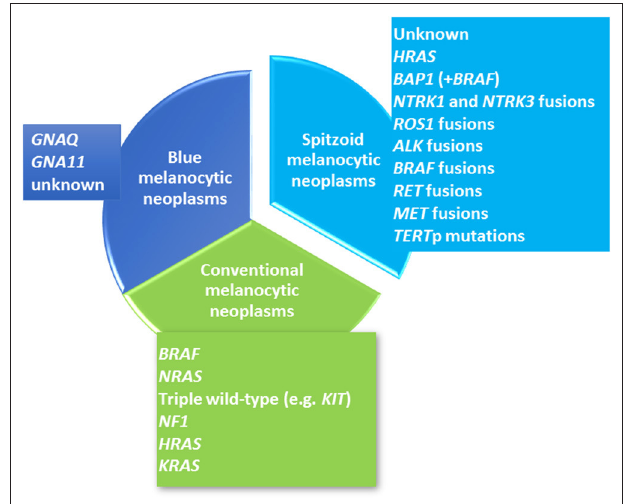
FIGURE 1 | Overview of the Molecular Landscape of Melanocytic Neoplasms. Cutaneous melanocytic neoplasms can be clustered into three major lines including conventional melanocytic neoplasms (colored in green), Spitzoid melanocytic neoplasms (colored in turquoise) and blue melanocytic neoplasms (colored in blue). Each group shows distinct molecular genetic alterations. Conventional melanocytic neoplasms (green color) include common melanocytic nevocellular nevi, congenital nevocellular nevi and cutaneous malignant melanoma. Common nevocellular nevi harbor activating hotspot BRAF mutations at codon 600 [ ∼ 80%, ( 1)]. The majority of congenital nevocellular nevi harbor activating NRAS hotspot mutations [ ∼ 75%, ( 2)]. Cutaneous malignant melanoma has been clustered into four molecular subtypes (3) with the largest subgroup harboring a BRAFV600E mutation ( ∼ 50%) and the second largest group with an activating NRAS mutation ( ∼ 25%) as well as HRAS and KRAS mutations ( ∼ 1%). The third subgroup shows NF1 inactivation ( ∼ 10%). The last molecular subgroup lacks BRAF, N/H/KRAS or NF1 mutations and represents a heterogeneous so called “triple wild-type subtype”. The second major line of cutaneous melanocytic neoplasms comprises blue melanocytic neoplasms which are also called dermal dendritic melanocytic neoplasms (blue color) and have been shown to harbor activating GNAQ and GNA11 mutations. GNAQ dominates in cutaneous proliferations while GNAQ and GNA11 is found in almost the half of uveal melanomas ( 4). The third group refers to Spitzoid melanocytic neoplasms (turquoise color) and shows quite different molecular genetic alterations which are rarely observed in the two other groups. Receptor tyrosine kinase translocations involving ALK, ROS1, NTRK1, NTRK3, BRAF, RET, MET ( 5–7) as well as HRAS (5, 8, 9), BAP1 (10), and TERT p mutations (11–13) have been described in Spitzoid